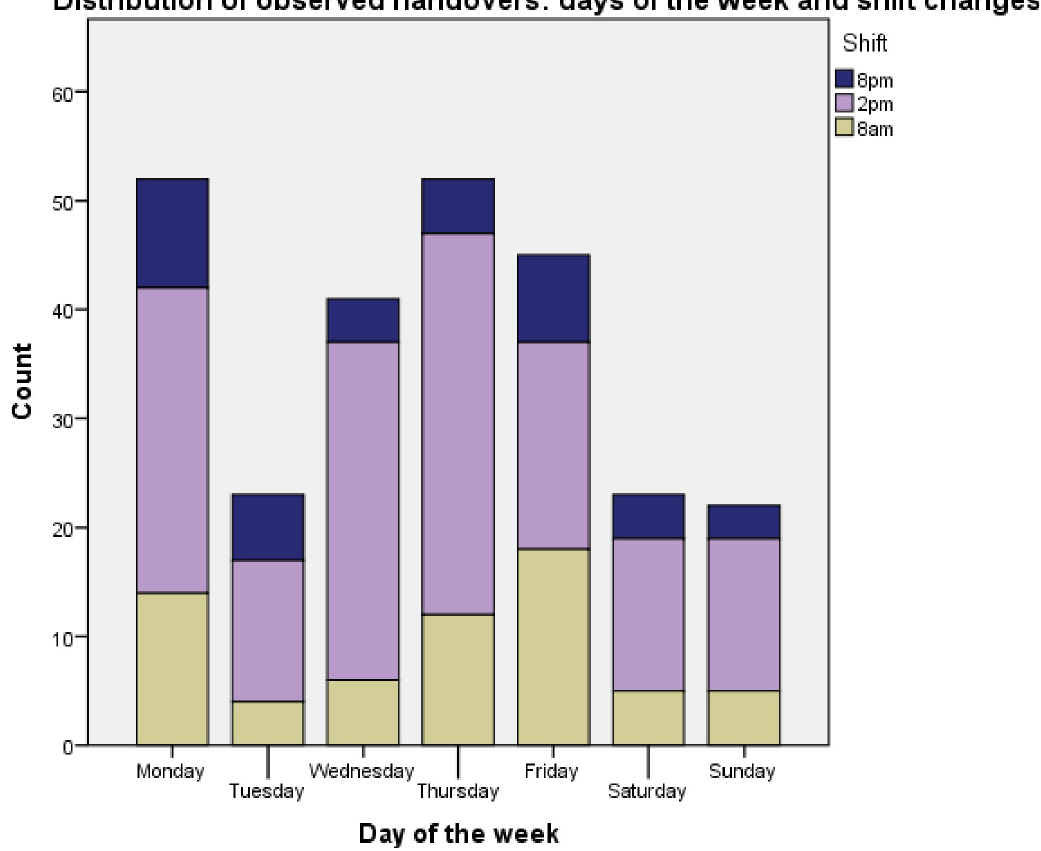
Fig 1. Graph showing spread of observations across days of week and shift